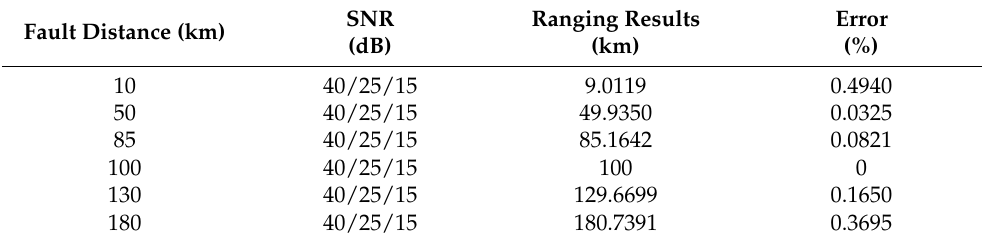
Table 3. Algorithm ranging accuracy verification under different proportions of